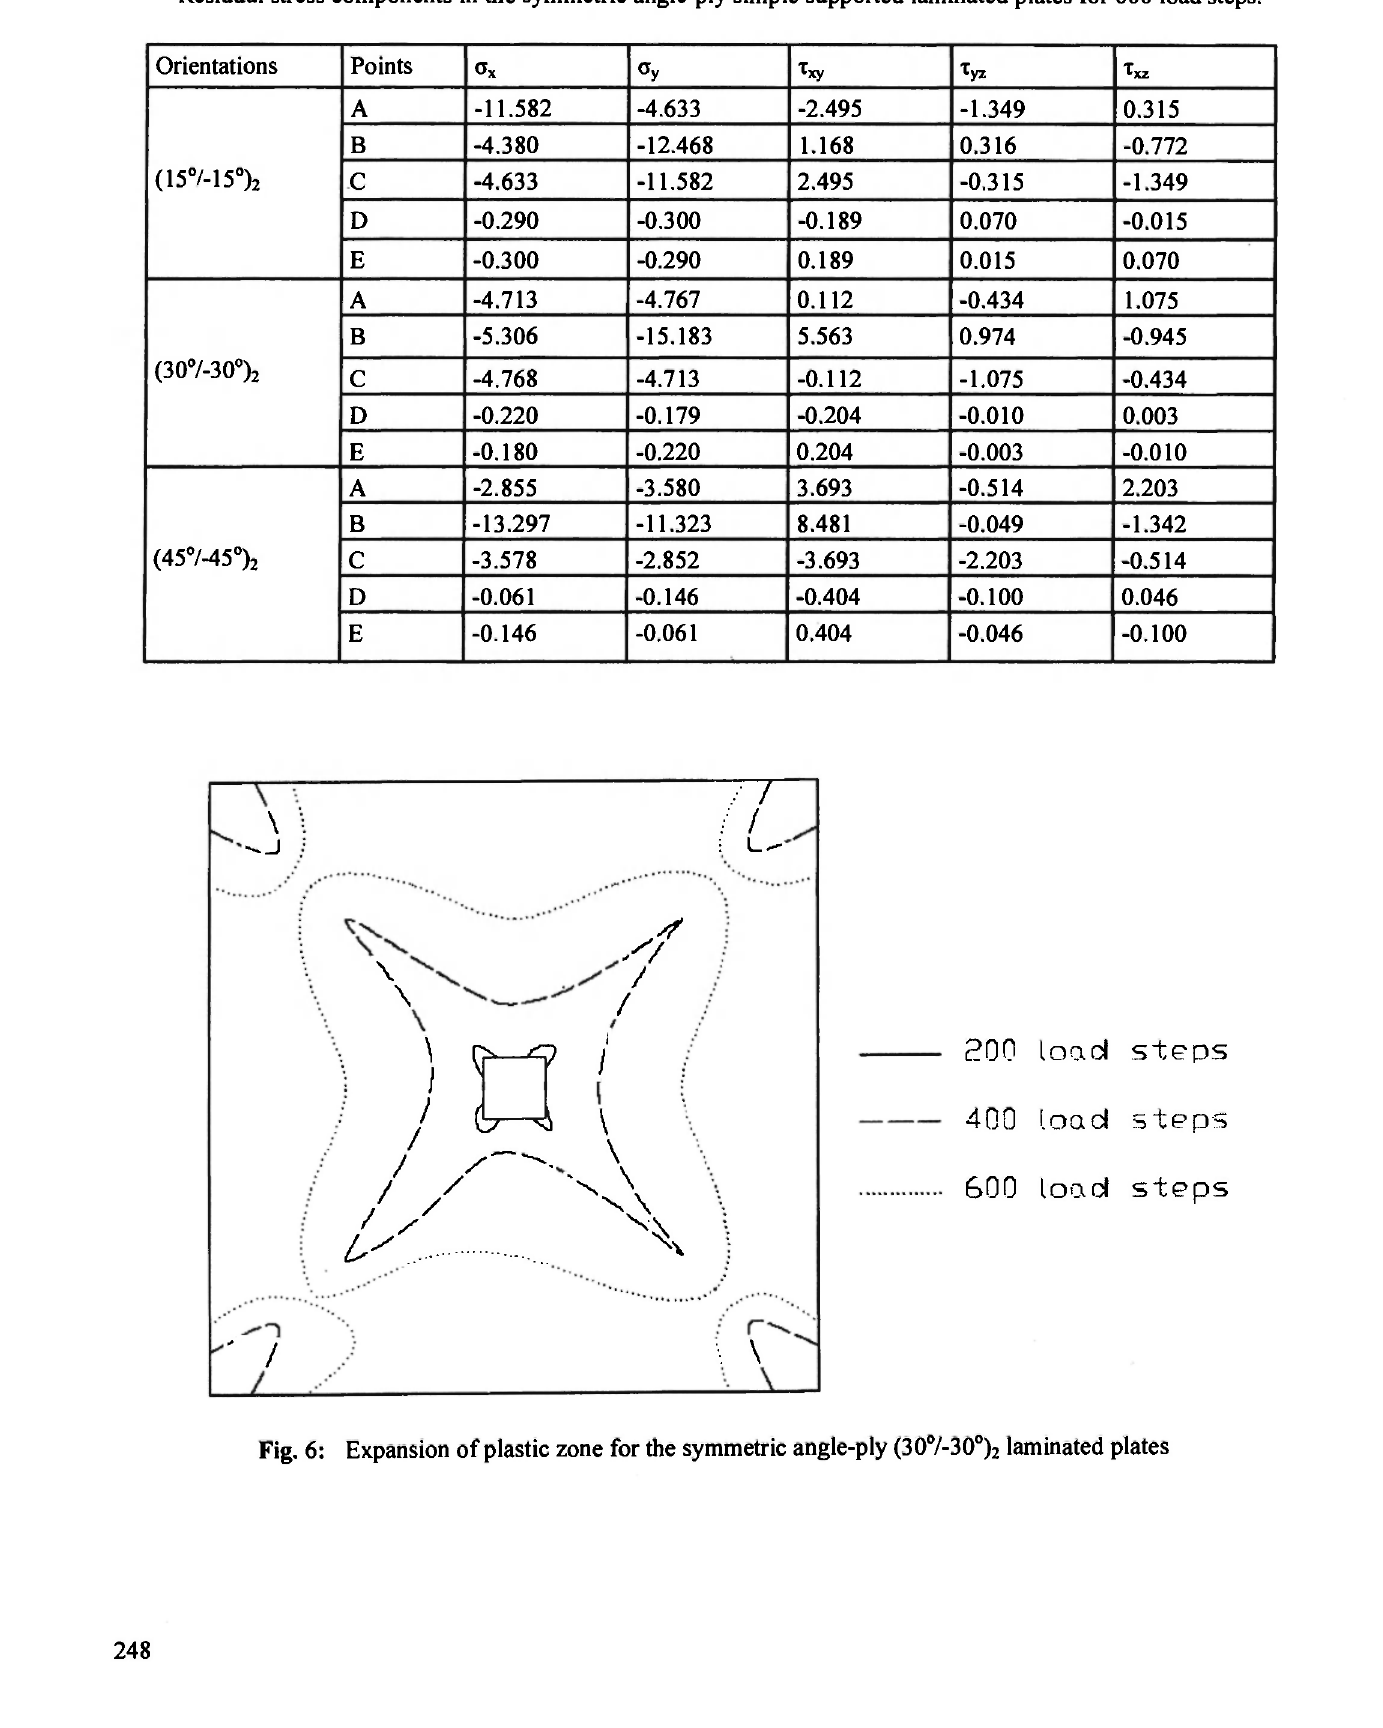
Residual stress components in the symmetric angle-ply simple supported laminated plates for 600 load steps.